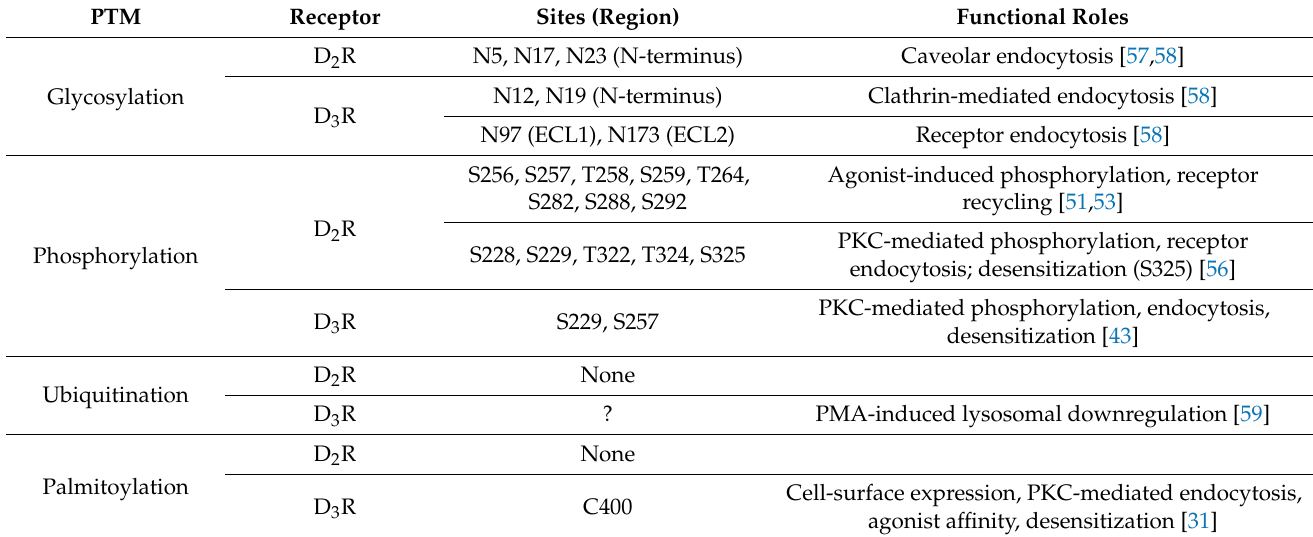
Table 1. Roles of posttranslational modification of dopamine D 2 and D 3